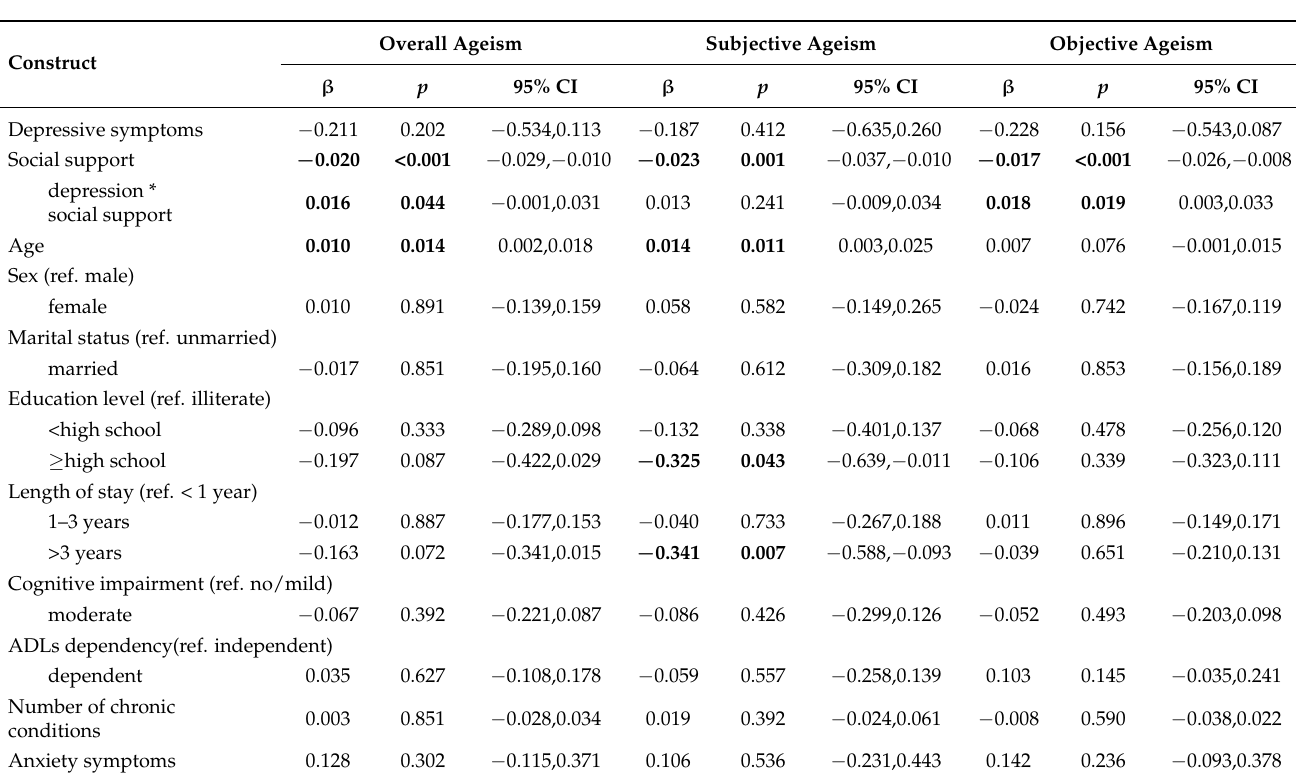
Table 3. The modifying role of social support in the relationship between depressive symptoms and ageism.